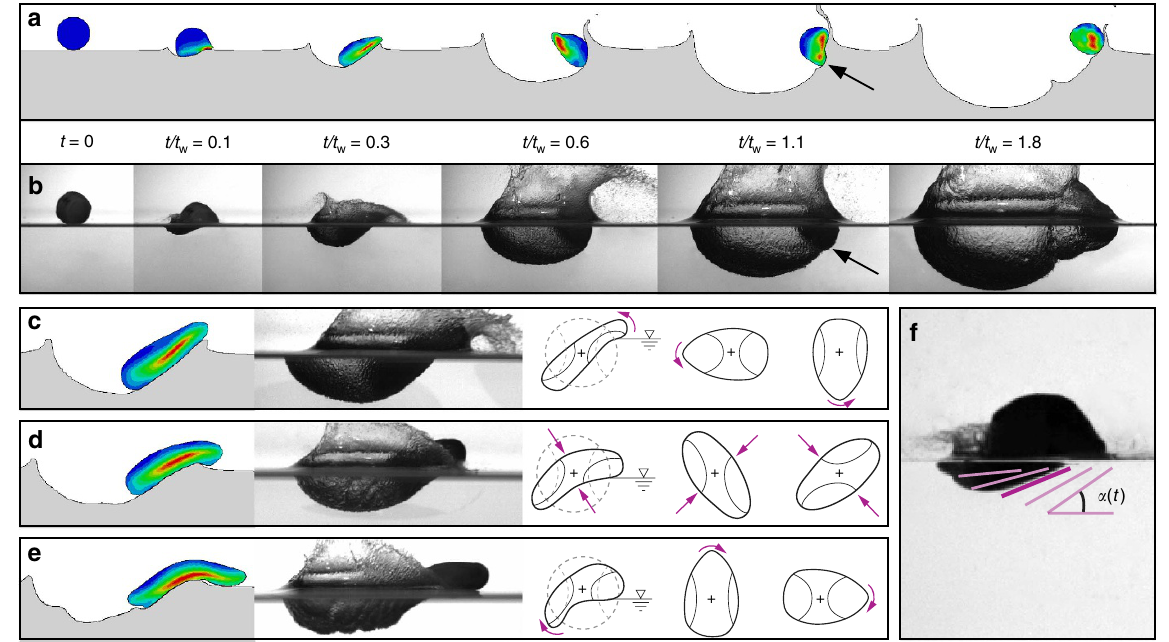
Figure 2 | Fluid-structure coupling through sphere deformation modes. ( a ) An Abaqus numerical model captures the skipping behaviour and reveals the local relative strain in the sphere (colour contours). ( b ) Under the same conditions as simulated in ( a ) an experiment shows the formation of a nested cavity (or so-called matryoshka cavity), as also shown by the model. ( a , c ) The model reveals an elastic wave that propagates in a counter-clockwise direction around the sphere (classified as deformation mode 1 (cid:2) ). At time t w , the elastic wave strikes the air–water interface. Two other deformation modes are observed; ( d ) mode 2: the sphere assumes an ellipsoidal shape with oscillating major and minor axes (Supplementary Movie 1); ( e ) mode 1 þ : an elastic wave propagates in the clockwise direction. ( f ) The attack angle a evolves in time in response to the elastic wave propagation (deformation mode 1 (cid:2) is pictured). The purple lines are experimental measurements of a taken at 1.33ms